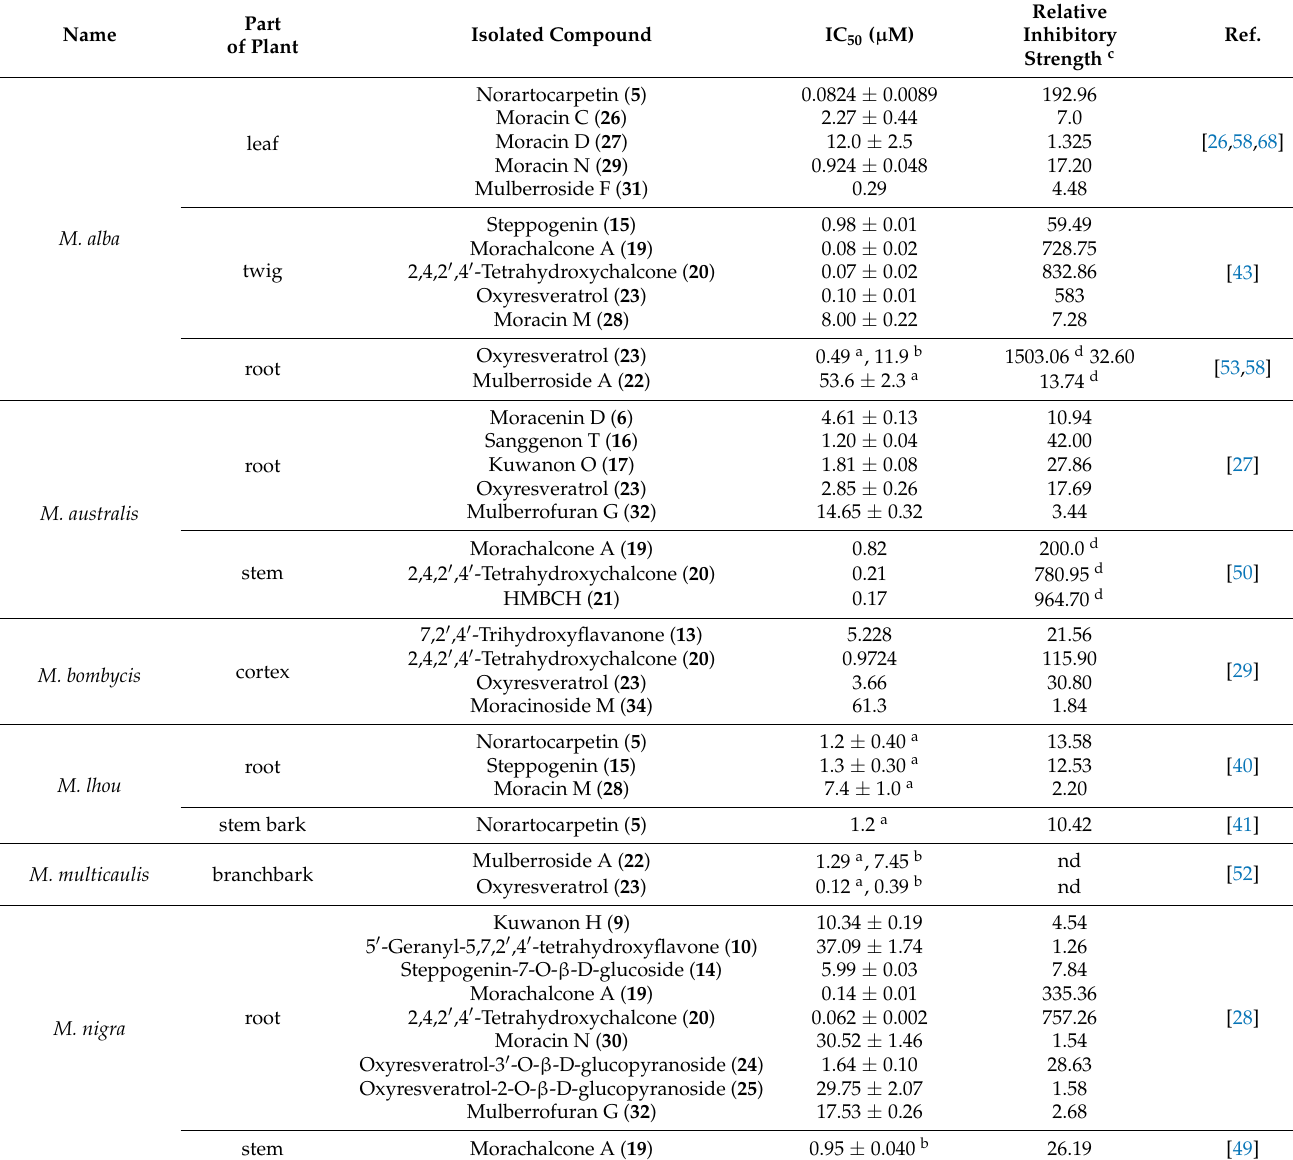
Table 1. Isolated natural compounds with most potent tyrosinase inhibitory activity from genus Morus